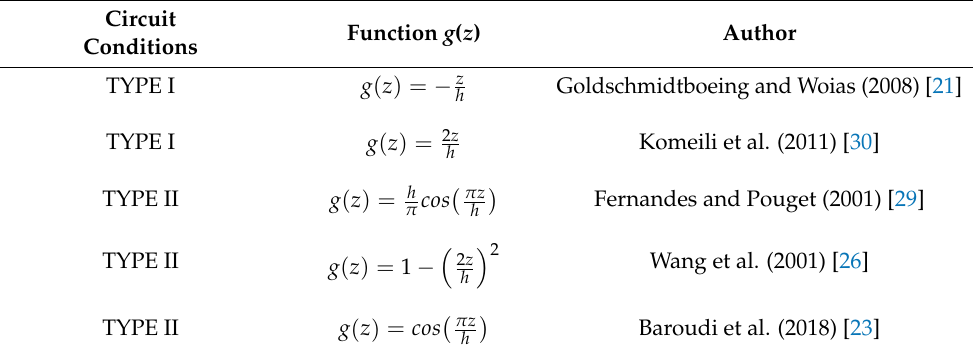
Table 2. Function g ( z ) describes the distribution of the electric potential along the thickness direction of the piezoelectric